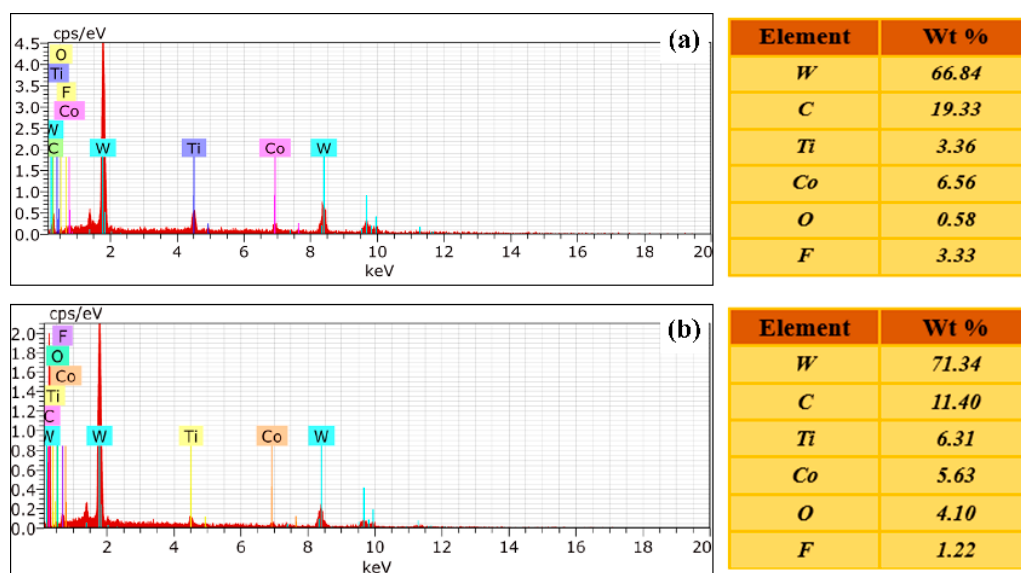
Figure 15. EDS results of the hydrophobic surface prepared using under-liquid laser machining (ULLM) method: ( a ) the amphiphobic surface prior to rubbing; ( b ) after 300 rubbing cycles.